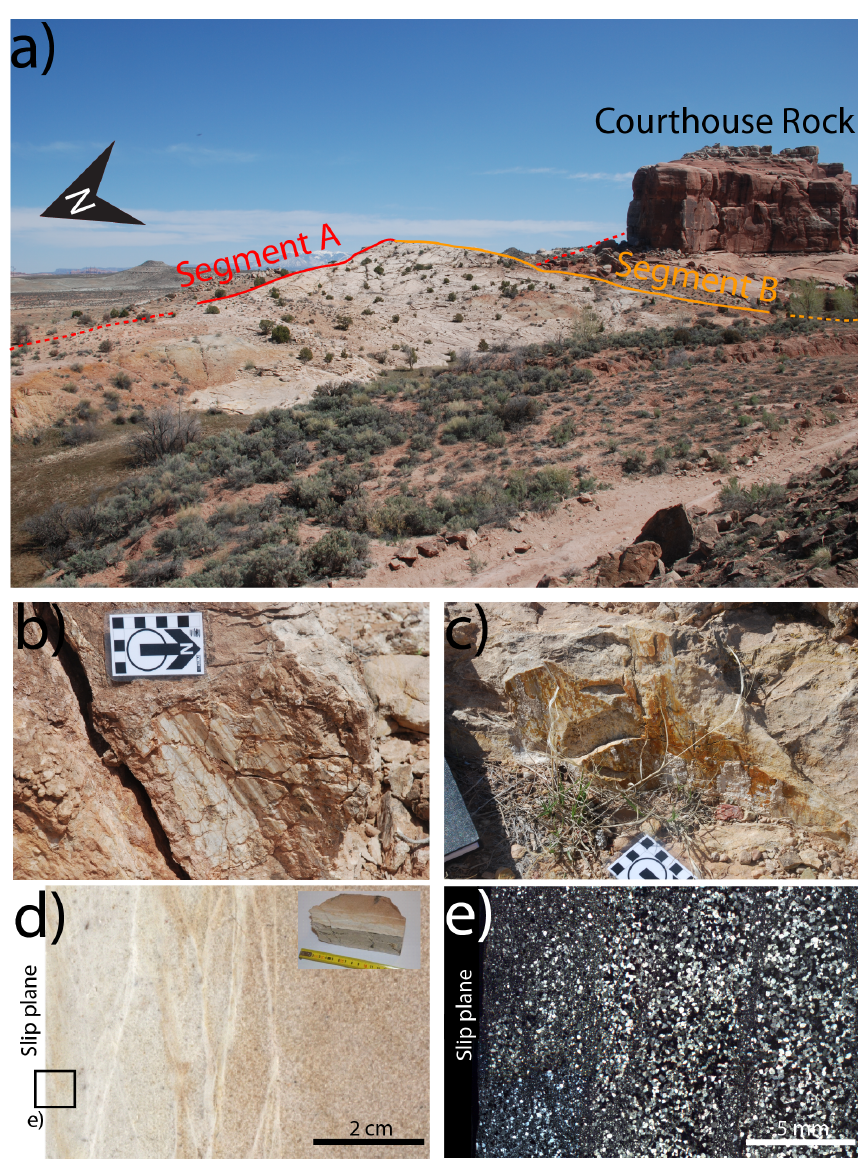
Figure 2. Outcrop and sample photos. (a) The CHJ, as seen from the NW. Larger deformation structures are already visible from this distance. See Fig. 1b for location and view direction of this photo. Panels (b) and (c) show typical examples of striated slip planes. (d) Photograph of a sample cut perpendicular to the slip plane and parallel to the striations. Note the increase in deformation band density towards the slip plane, as well as the bleaching of the sandstone near the slip plane. A picture of the sample is shown in the inset. (e) Photomicrograph with crossed polarizers; a thin section of the sample shown in (d) . The deformation bands are clearly cataclastic. Deformation band density increases towards the slip plane at this scale